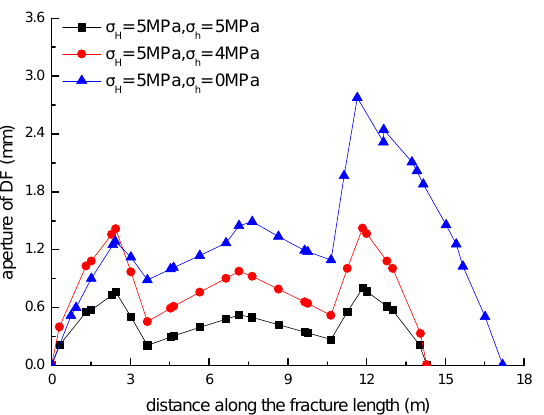
Figure 12. The fracture aperture curves of the DF along the fracture length at different levels of remote horizontal principle stress difference. The distance in the x -axis is along the direction from the lower part to the upper part of the DF.